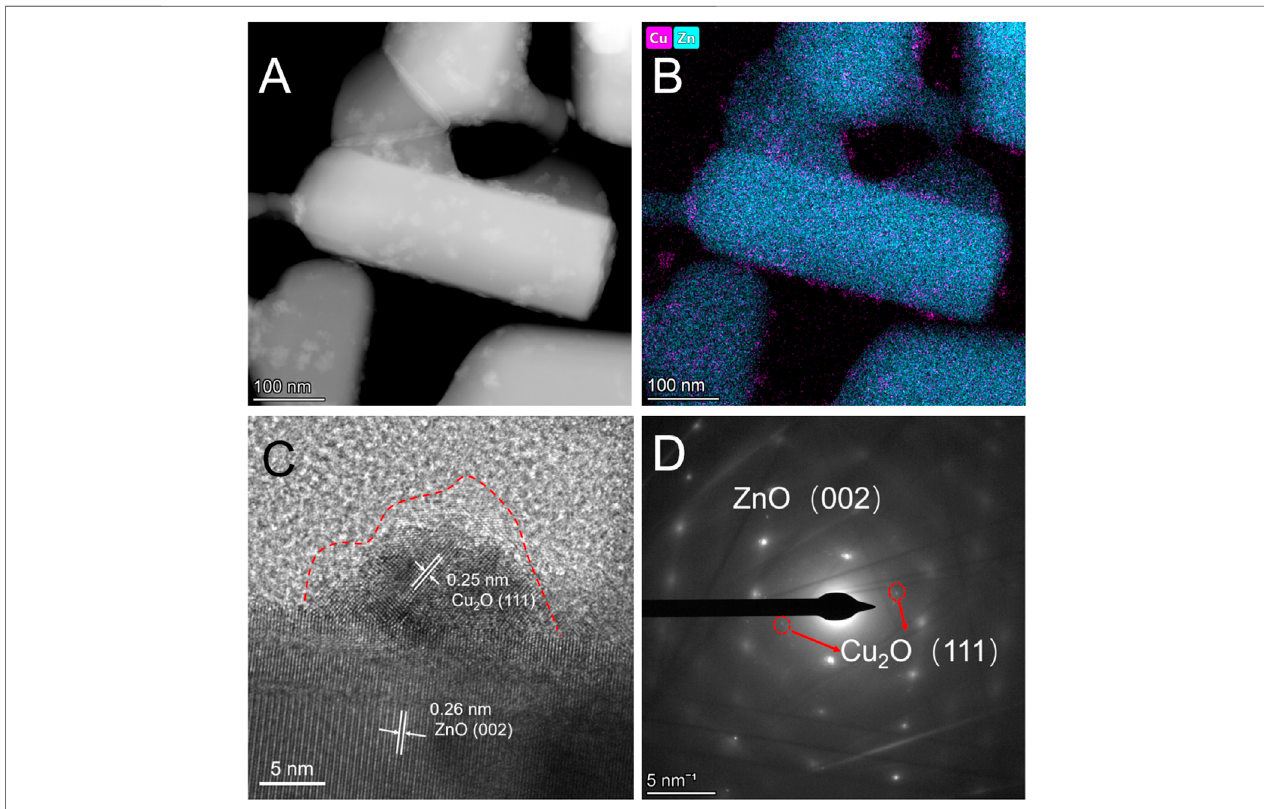
FIGURE1|(A) High-angle annular dark- fi eld scanning transmission electron microscopy images, (B) energy dispersive X-ray mapping, (C) high-resolution transmission electron microscopy, and (D) selected-area electron diffraction patterns of Cu x O/ZnO-12